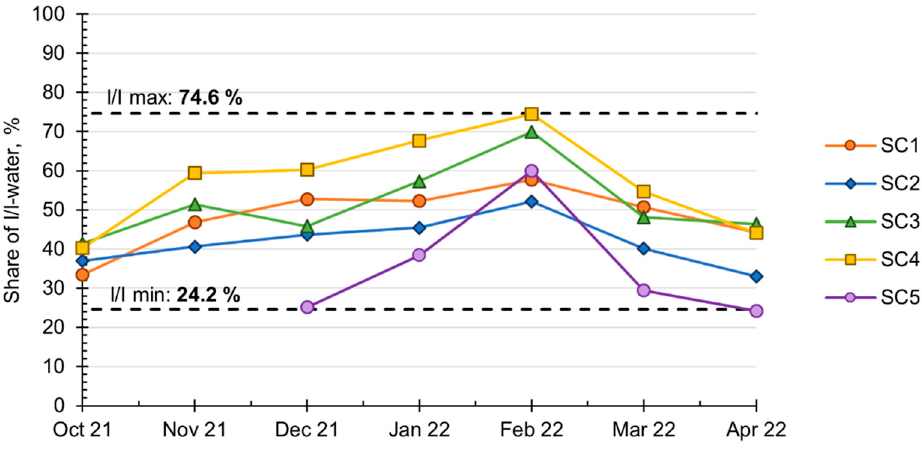
Figure 4. Results of WBM during the study period.